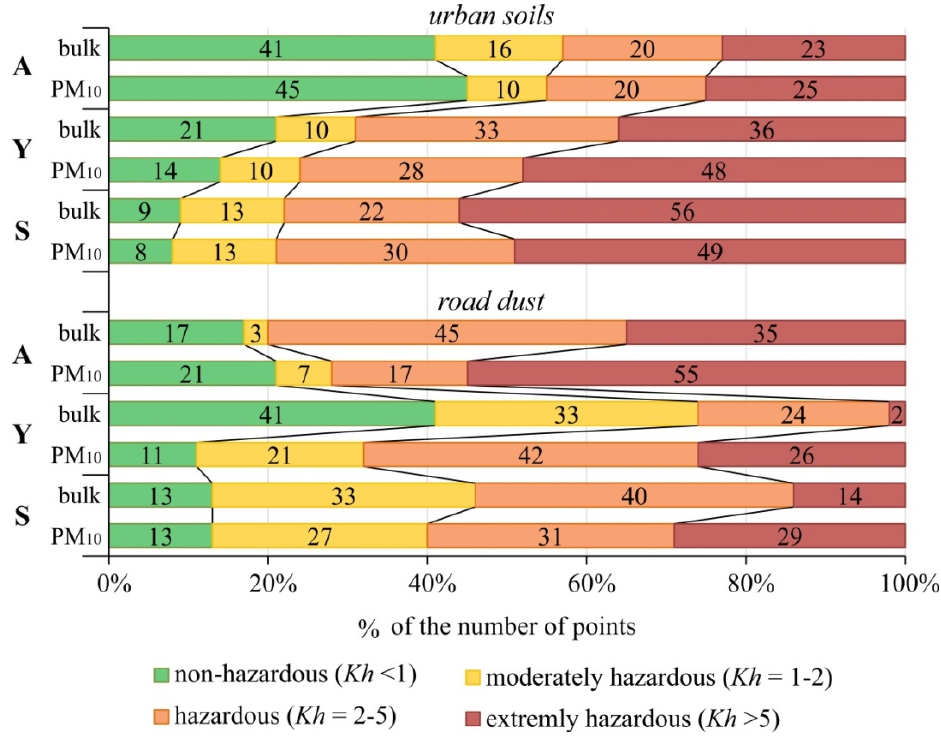
Figure 8. Levels of environmental hazard of benzo(a)pyrene contamination of urban soils, road dust and their PM 10 fractions in Alushta (A), Yalta (Y) and Sebastopol (S).